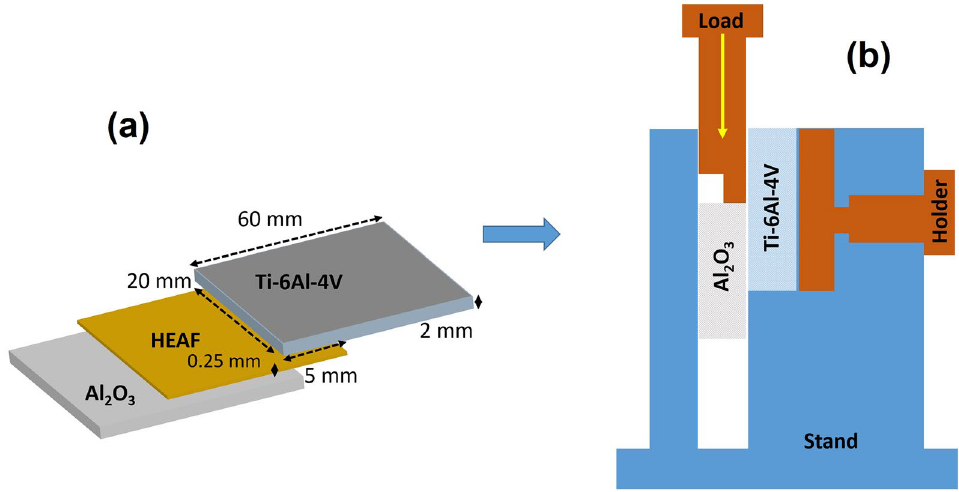
Figure 3. ( a ) Joint structure for ( b ) shear test evaluation.